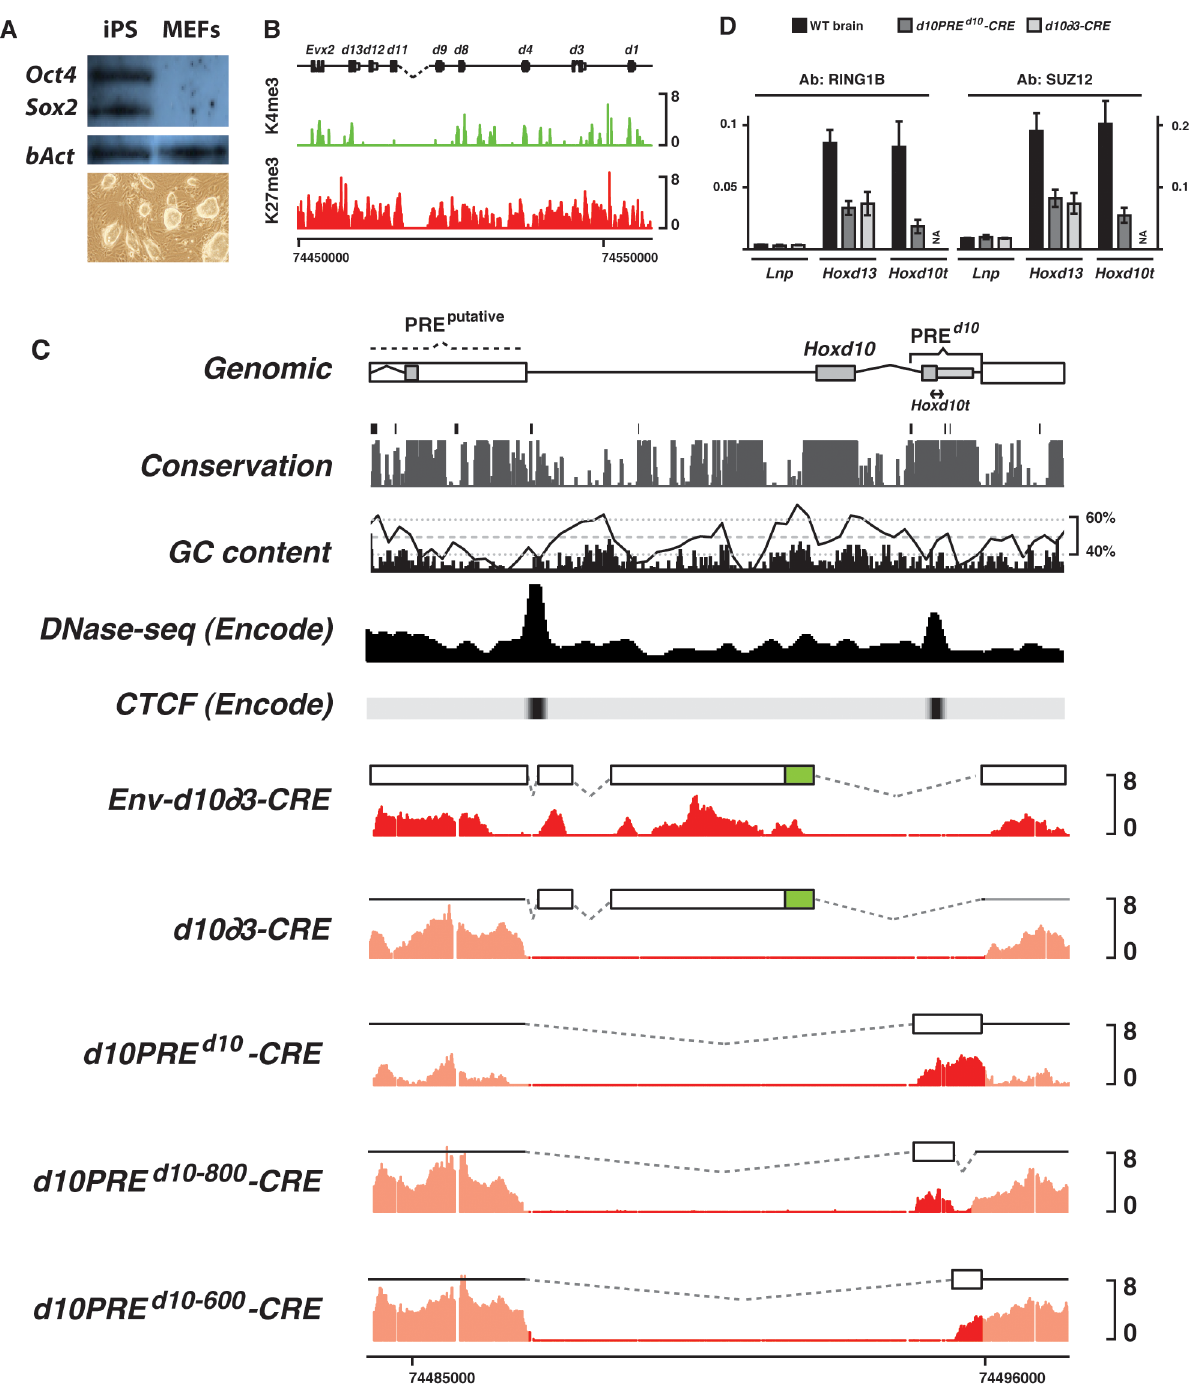
Figure 5. H3K27me3 profiles of transgenic constructs in iPS cells. (A) Western blot for pluripotency markers and morphology of the iPS del(Hoxd10) clone. (B) Chromatin signature of iPS cells with the observed reactivation of bivalent domains over most Hoxd genes. (C) H3K27me3 (red) profiles of various constructs electroporated into iPS cells carrying a deletion of Hoxd10 . The electroporated construct is depicted by the white box above each profile. Env- corresponds to transgenes carrying arms for recombination, homologous to Hoxd11 and the 3 9 portion of Hoxd10 , respectively. CRE indicates single copy integrants. Black line in the GC content panel corresponds to a running window of 200 bp. PREd10 overlaps with sites of DNase hypersensitivity and experimentally validated CTCF sites. (D) ChIP-qPCR of PRC1 ( Ring1B ) and PRC2 ( Suz12 ) over various regions of the HoxD cluster. Consistent with the presence of H3K27me3, PRC1/2 binds randomly integrated PREd10 at levels comparable to that found in the endogenous Hox locus ( Hoxd13 ).